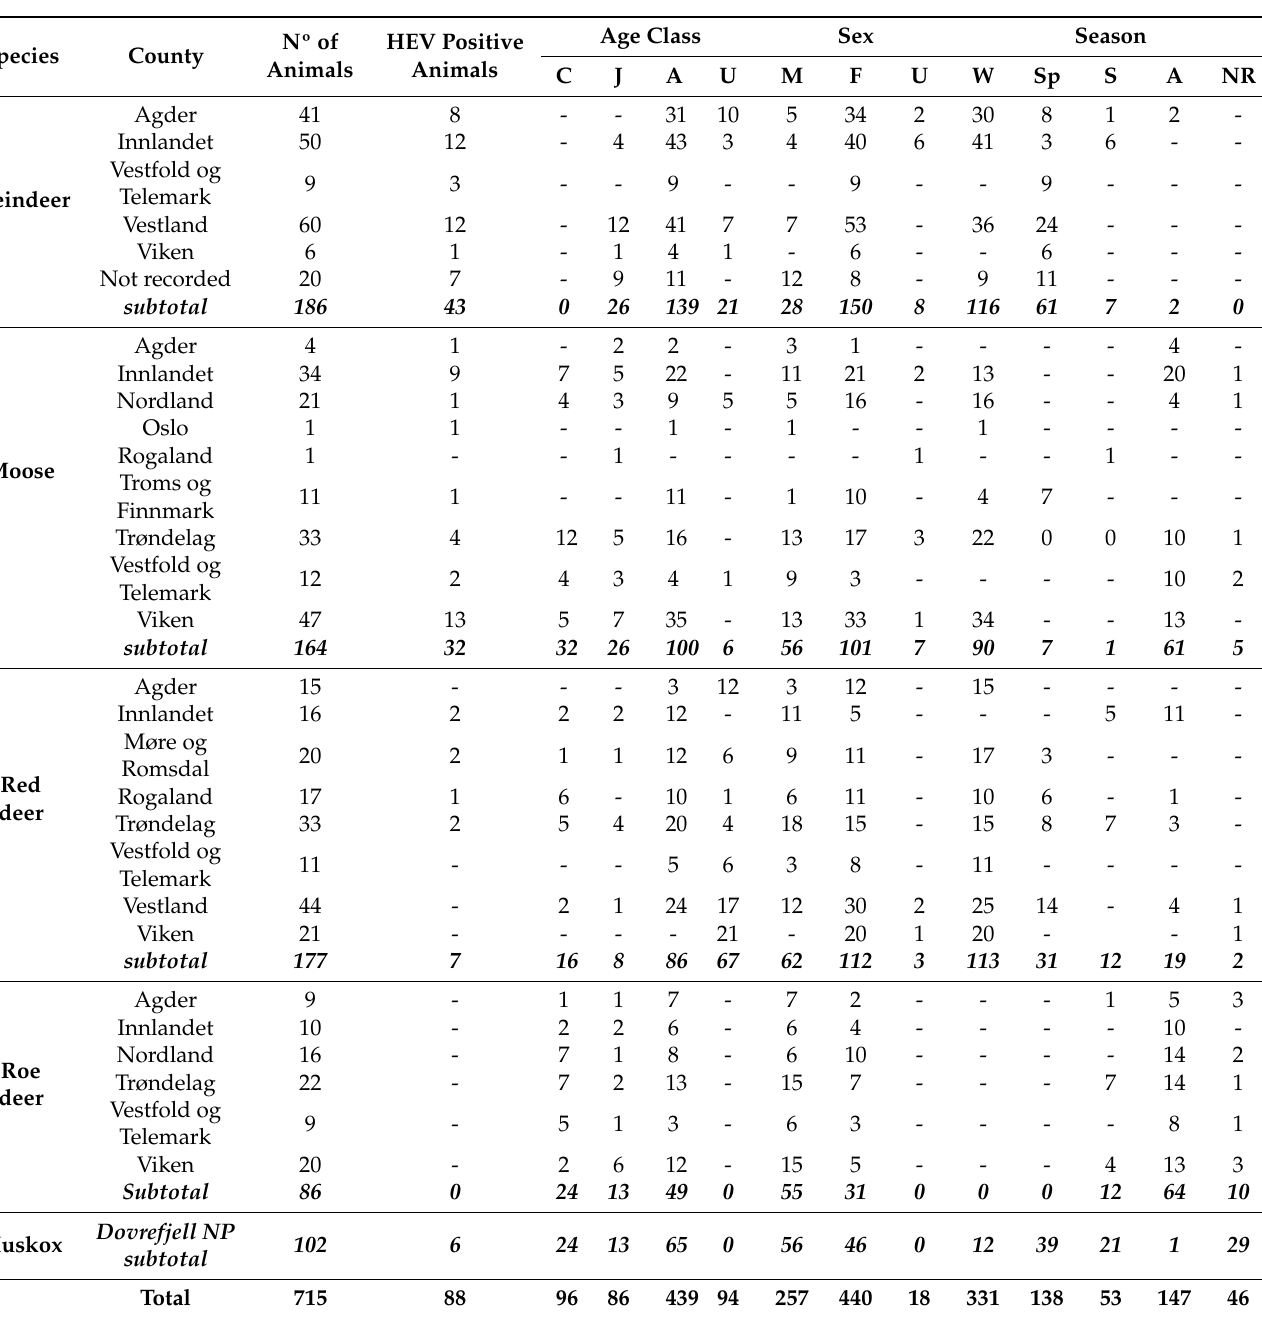
Table 1. Age class (C = calf, J = juvenile, A = adult, U = unknown) and sex (M = male, F = female, U = unknown) of the tested moose ( Alces alces ), red deer ( Cervus elaphus ), European roe deer ( Capreolus capreolus ), Eurasian tundra reindeer ( Rangifer tarandus ), and muskoxen ( Ovibos moschatus ) included in the study, and season of sampling (W = winter, Sp = spring, S = summer, A = Autumn, NR = not